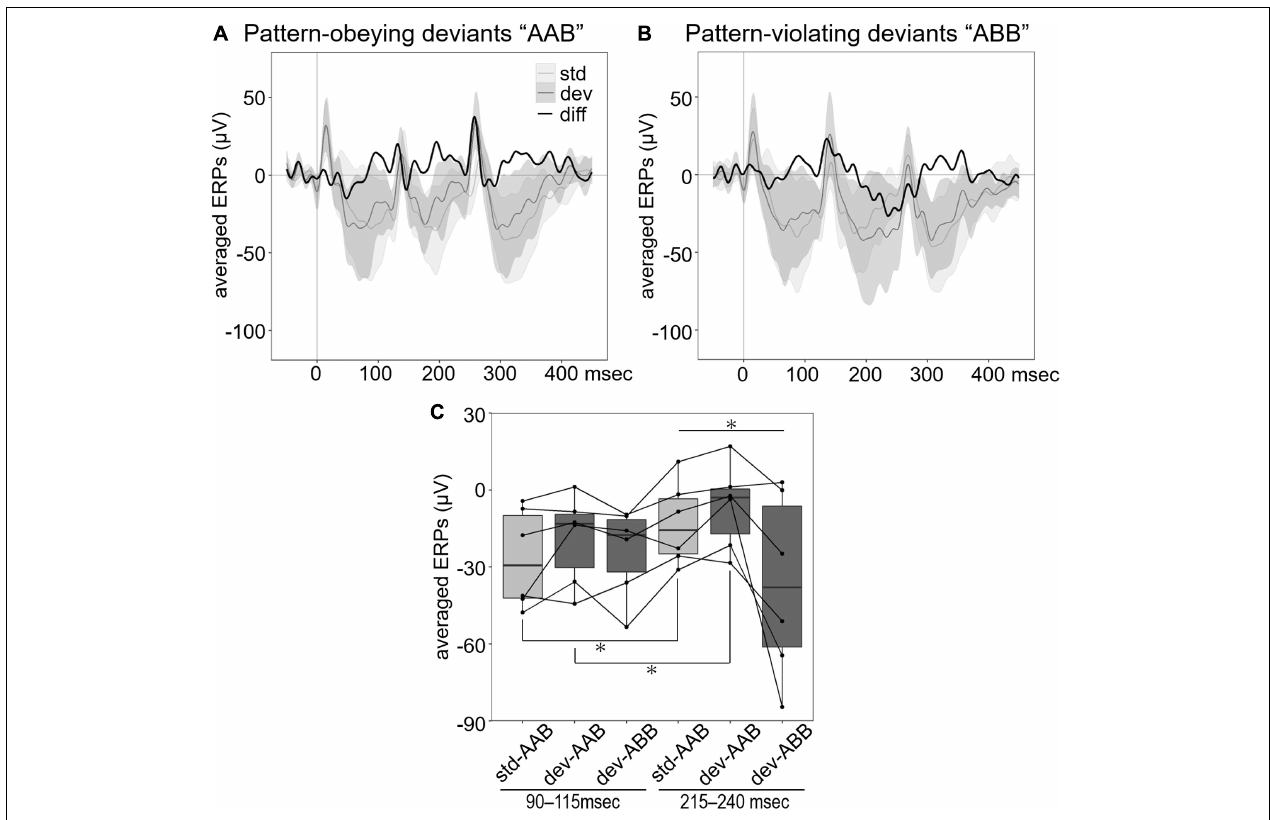
FIGURE 3 | Averaged ERPs to triplet sequences. (A) Group averaged ERPs to standard “AAB” (light gray line) and pattern-obeying deviants “AAB” (dark gray line). (B) Group averaged ERPs to standard “AAB” (light gray line) and pattern-violating deviants “ABB” (dark gray line). Black line in both (A,B) shows the difference wave obtained by subtracting the ERPs to standard stimuli from the ERPs to deviant stimuli. The shading indicates the range of 95% CI of the waves. (C) Each box shows the quartiles of the ERPs to standard (light gray) and deviant (dark gray) stimuli in each time window (90–115 ms for the first sound, 215–240 ms for the second sound in the triplet sequence). Each dot represents the averaged ERPs for each individual ( n = 6). The line connects data of the same individual. The negative waveform of ERPs to the second sound of triplet sequences reduced in standard “AAB” and pattern-obeying deviants “AAB” compared with pattern-violating deviants “ABB” (repeated measures ANOVA, ∗ p <